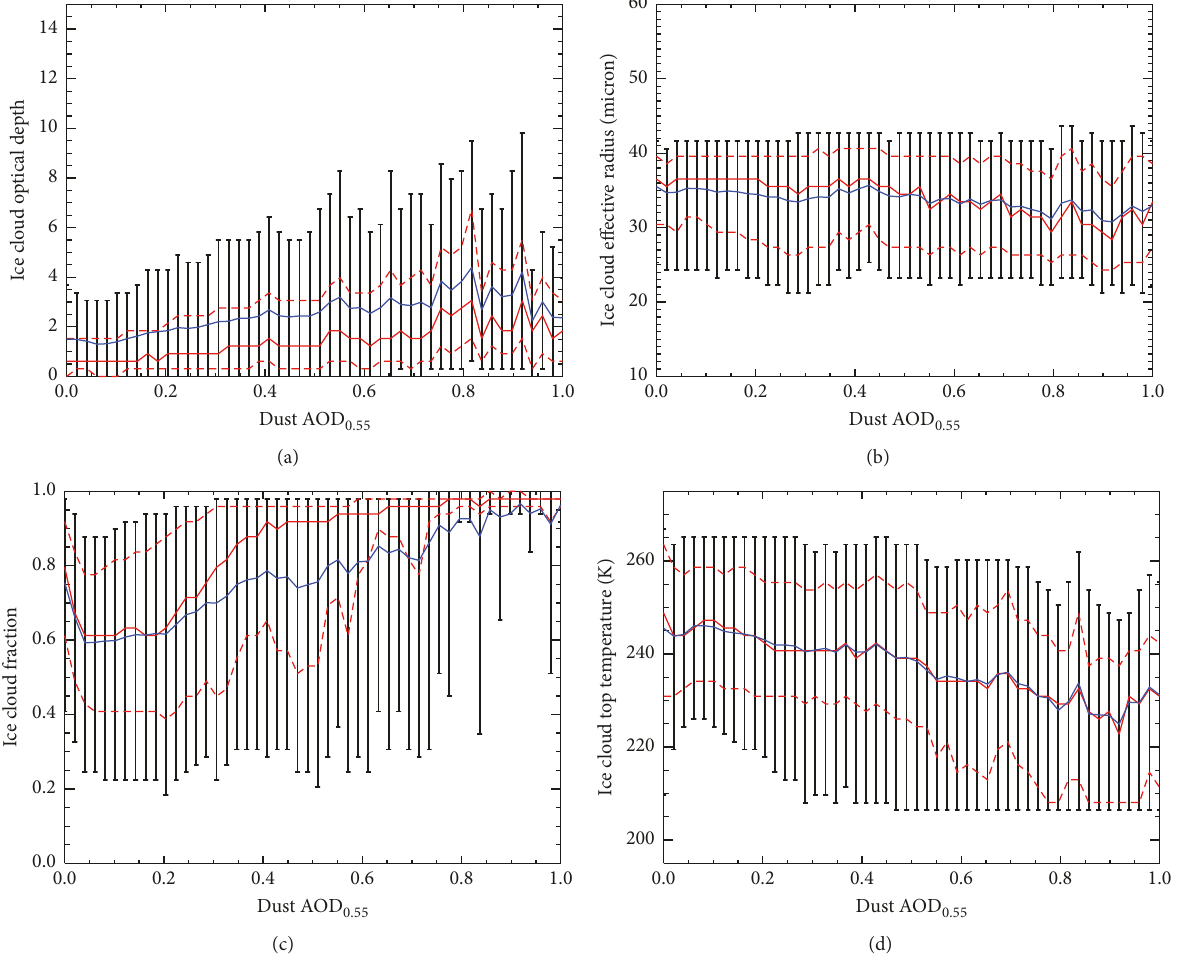
Figure 7: Representation of COD (a), 𝑅 (b), CFC (c), and CTT (d) distribution for 50 bins of AOD dust between 0 and 1.0. In each plot, the eff red solid line represents the distribution median value, the blue line is the mean, the dashed red lines are deliminations for the 25th and 75th percentiles, and the bars represent the 10th and 90th